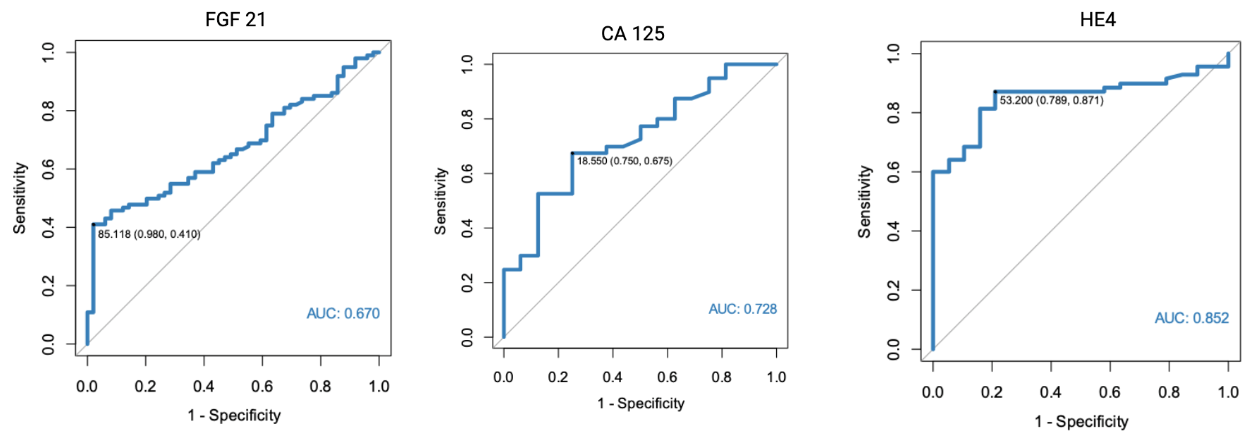
Figure 3. ROC curve analysis of FGF 21, CA 125, and HE4 performance in EC diagnostics (endometrial cancer vs. endometrial polyps).